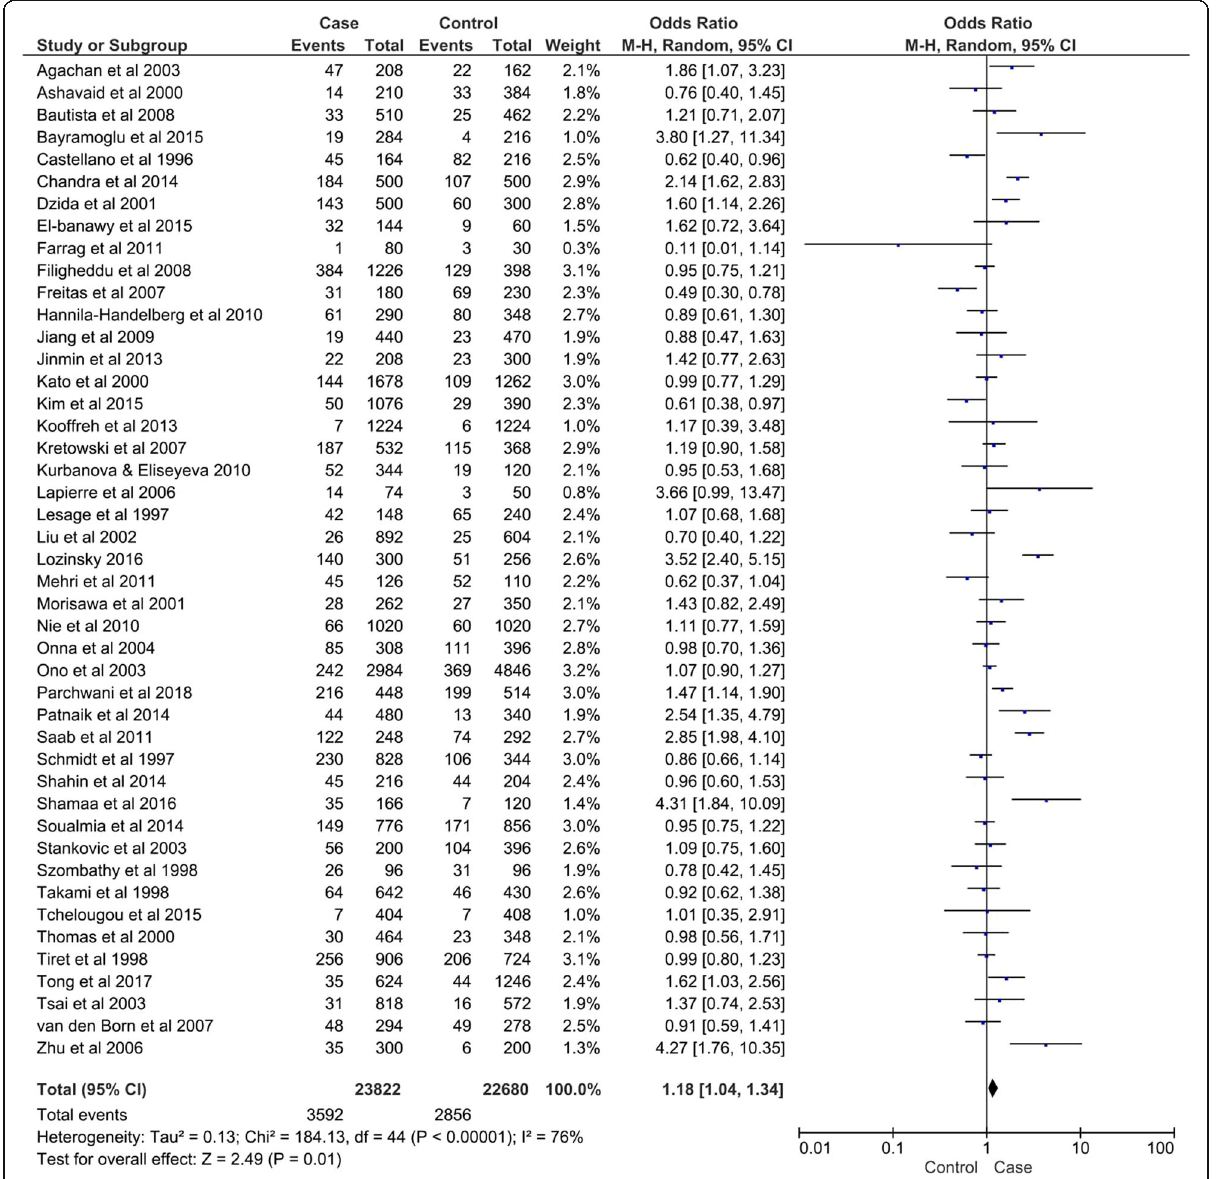
Fig. 2 Forest plot of the association between AT1R A1166C gene polymorphism and the risk of essential hypertension (C vs.